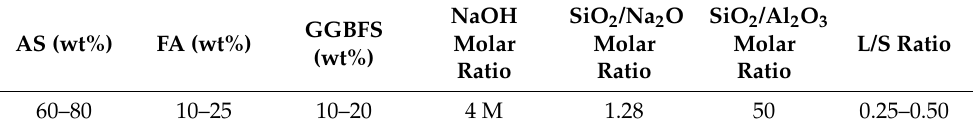
Table 5. The preparation parameter of AFG geopolymer